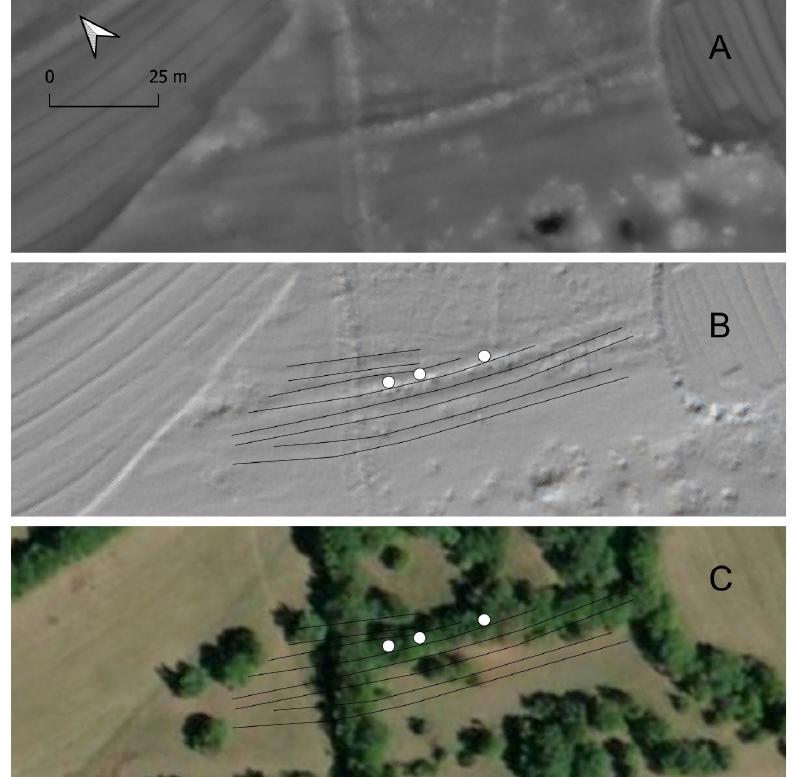
Figure 6. Zoomed view of area B of Figure 2, where several subparallel road tracks have been identified. The position of road tracks is indicated by black lines in pictures ( B ) (hill-shaded image of an ALS-derived DTM) and ( C ) (satellite image). Picture ( A ) is a local relief model of an ALS derived DTM. Associated caliga hobnails are indicated by white circles.